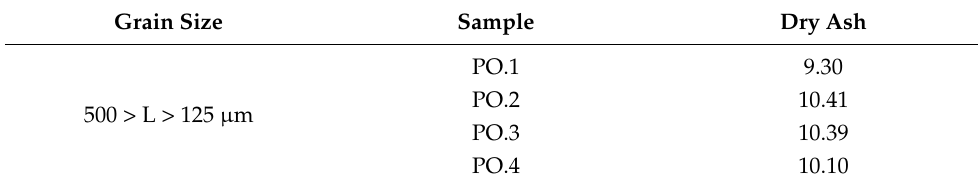
Table 4. Ash after the sieving of Posidonia oceanica .